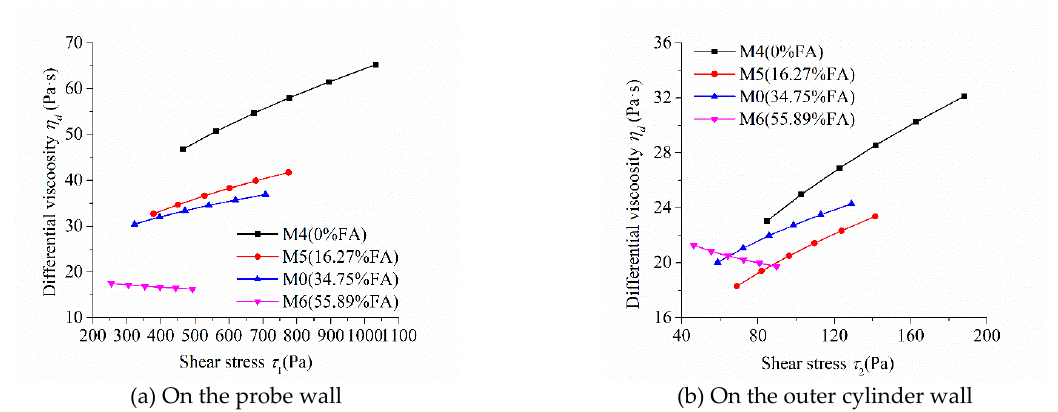
Figure 10. Relationship between the differential viscosity and shear stress of mortars with different FA contents.